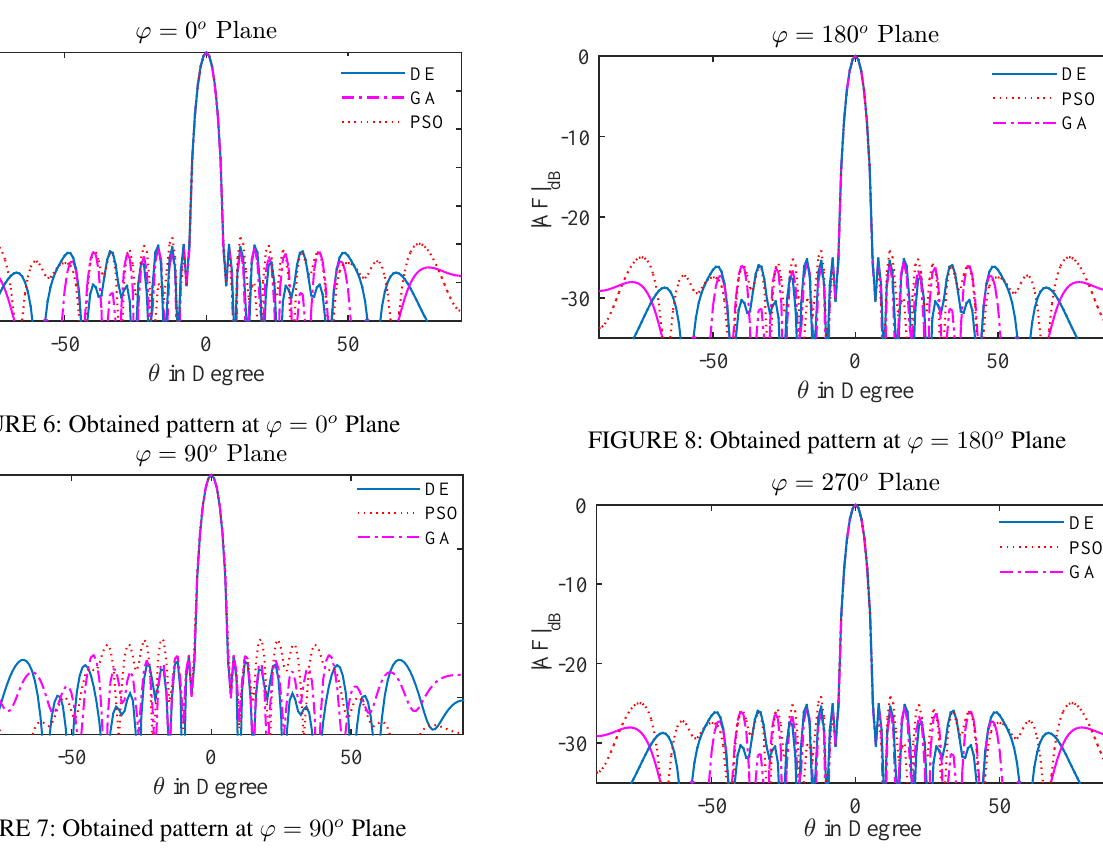
FIGURE 9: Obtained pattern at ϕ = 270 o Plane